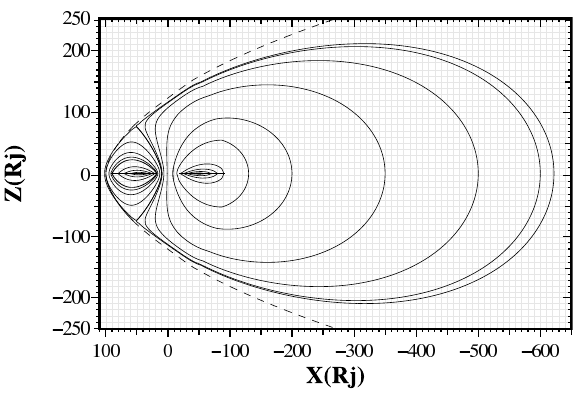
Fig. 6. Noon–midnight meridional cross section. The magnetic Fig. 6. Noon(cid:150)midnight meridional cross-section. The magnetic (cid:2)elds are caused by the jovian fields are caused by the Jovian magnetodisc and its screening mag- magnetodisc and its screening magnetopause current. The magnetic (cid:2)eld points south at the equa- netopause current. The magnetic field points south at the equator. The magnetopause is shown by the dashed line. The chosen param- tor. The magnetopause is shown by the dashed line. The chosen parameters: R ss = 100 R J ; eters: R ss = 100 R J ; R D1 = 92 . 07 R J ; R D2 = 18 . 4 R J ; B DC = 2 . R D1 = 92 . 07 R J ; R D2 = 18 . 4 R J ; B DC = 2 . 5 nT.